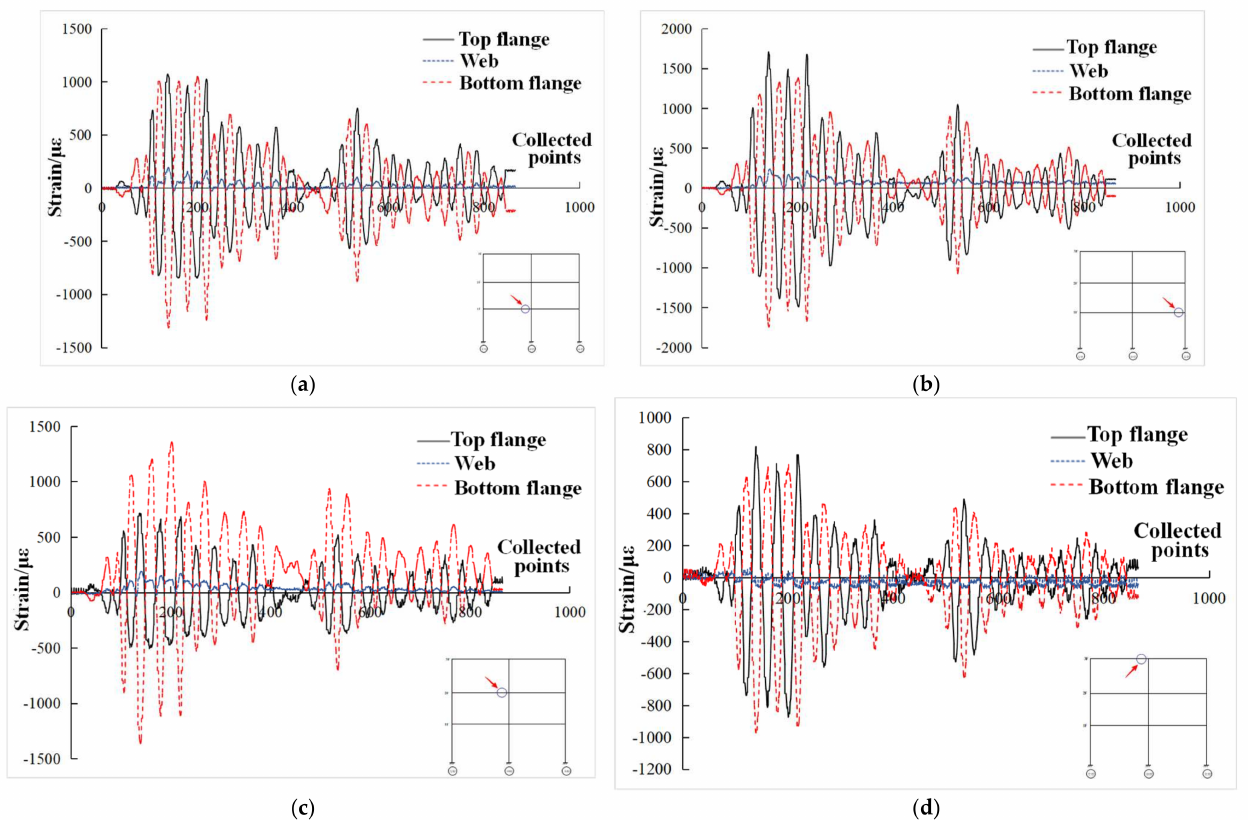
Figure 18. Strain of beam end. ( a ) Strain at left beam end of middle node in first layer; ( b ) Strain at beam end of one layer of right side joint; ( c ) Strain at the left beam end of the middle node in second layer; ( d ) Strain at left beam end of third layer middle